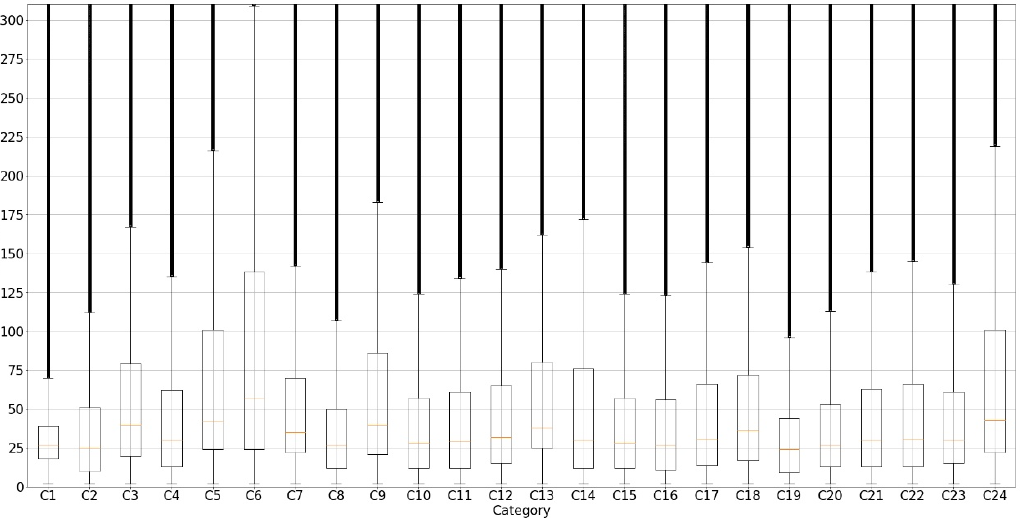
Figure 6. Boxplots of review lengths (no. of tokens) in 24 categories.